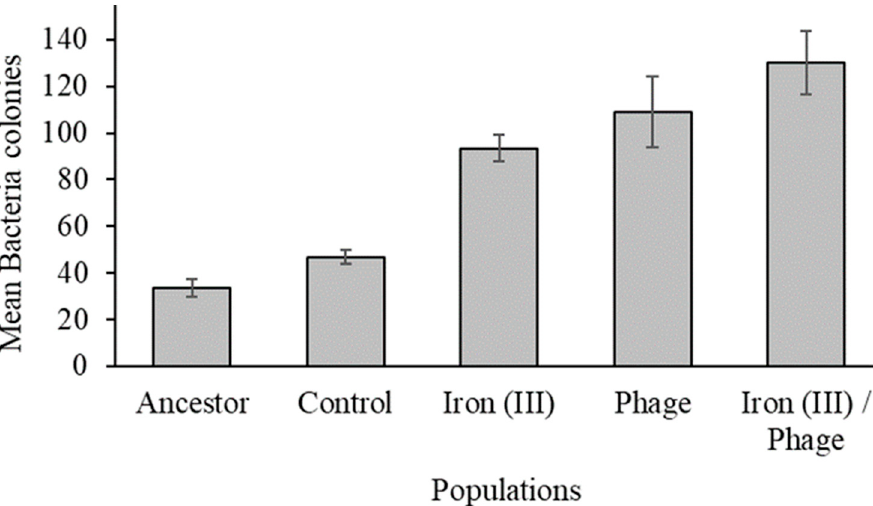
Figure 4. Dual resistance of populations to bacteriophage T7 and iron (III). Mean number of resistant colonies represents an average of 10 replicates and SE per population. Iron (III)/phage-resistant, phage-resistant, and iron (III)-resistant populations, in that order, were better fitted in excess iron (III) and T7 bacteriophage simultaneously. Ancestral population shows least resistance, followed by control. Differences in dual resistance to T7 bacteriophage and iron (III) were significant at 95% con fi dence interval among populations.